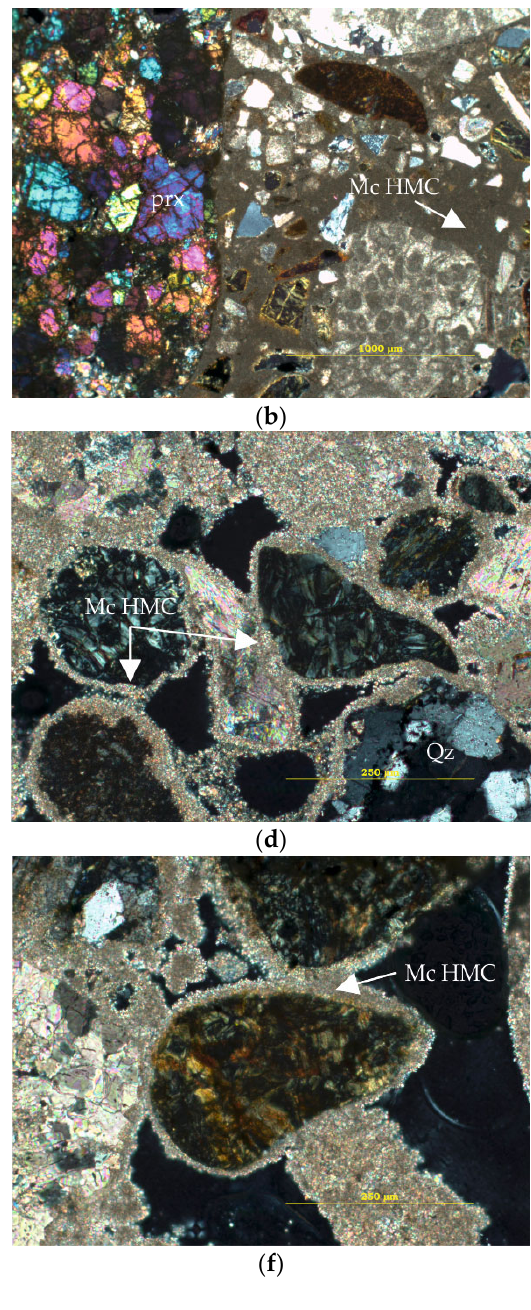
Figure 5. Representative photomicrographs under crossed polars illustrating beachrock composition. The photomicrographs are taken from polished thin sections of beachrock samples where Mc: microcrystalline or micritic cement, HMC: high magnesium calcite cement, MC: magnesium calcite, Qz: quartz, prx: pyroxene. Microcrystalline cement with a light brown color is indicative of HMC coating. ( a ) Thick microcrystalline HMC cement coats lithoclasts and minerals in sample S1E, ( b ) micritic HMC cement is developed playing the role of pore filling in sample S1F, ( c ) thick micro ‐ crystalline HMC cement coats lithoclasts and minerals in sample S2E, while in ( d ), thick microcrystalline HMC cement binds grains while forming pore ‐ filling forms in sample S2F. ( e ) Well ‐ devel ‐ oped sparitic crystals of MC filling all beachrocks pores in sample S3E and ( f ) thick microcrystalline HMC cement coats lithoclasts while forming pellets and pore ‐ filling forms in sample S3F.